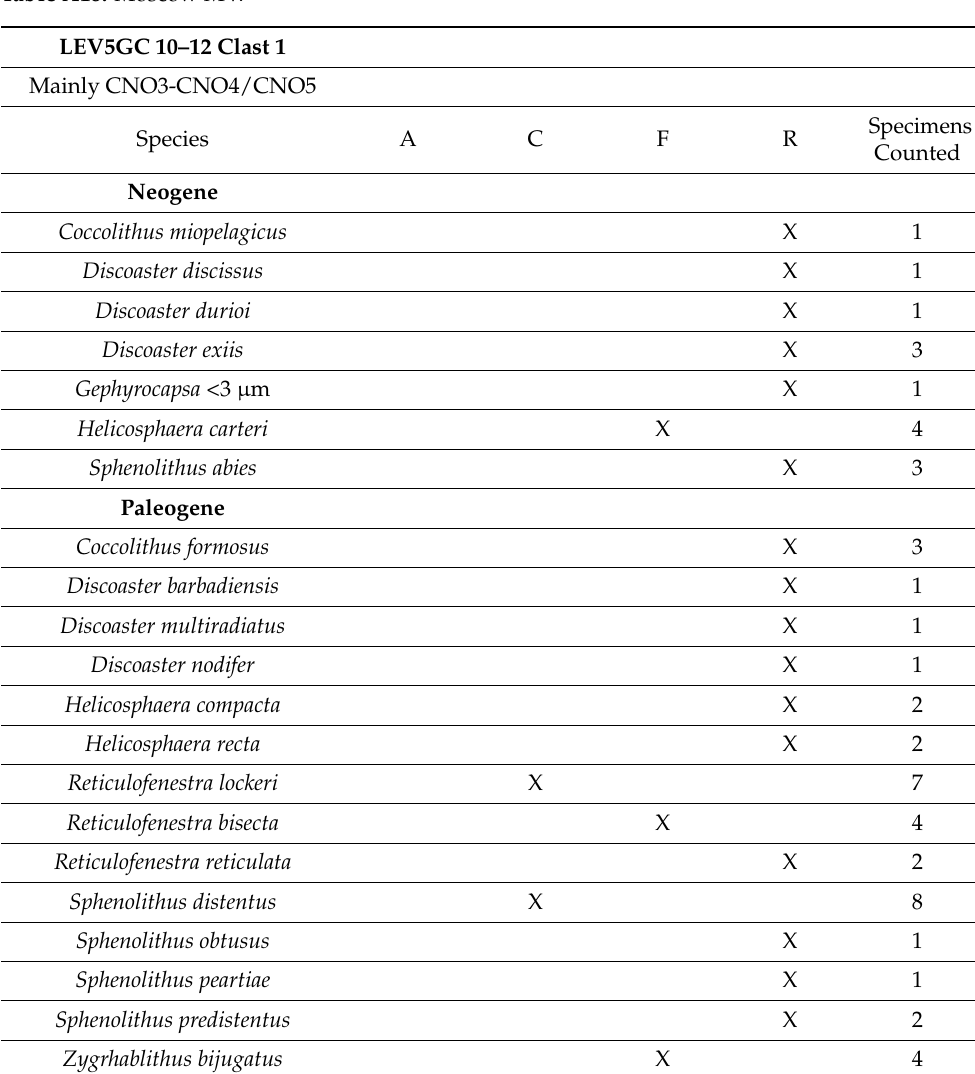
Table A18. Moscow